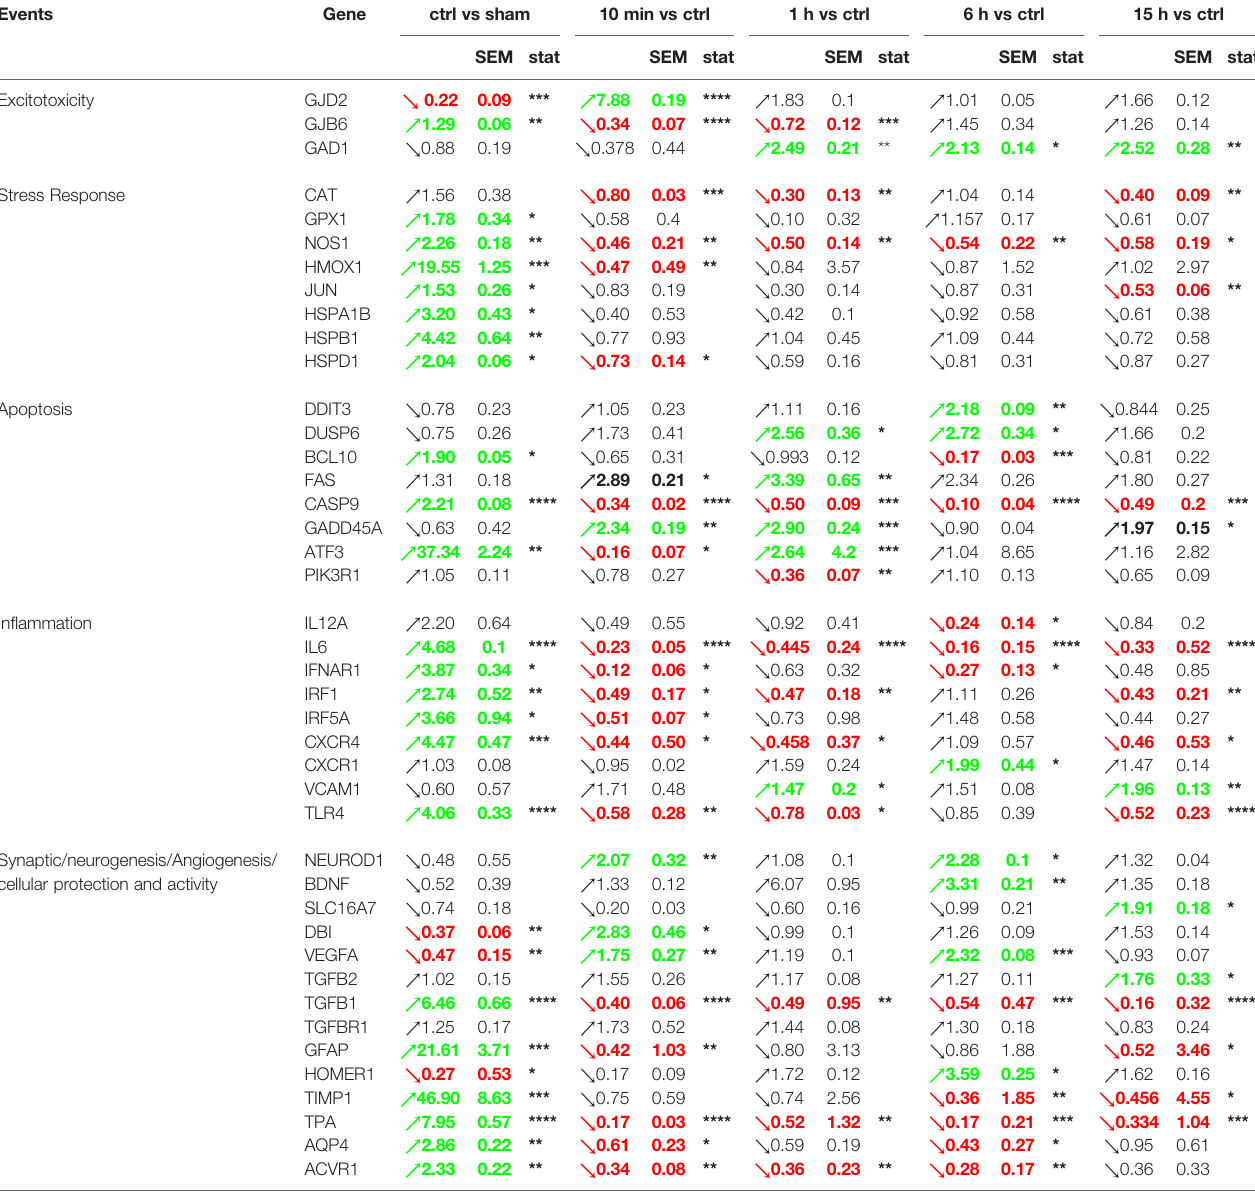
TABLE 1 | Effect of acute and delayed IN PACAP administration after reperfusion (tMCAO protocol) on gene expression measured 48 h after the occlusion. Events Gene ctrl vs sham 10 min vs ctrl 1 h vs ctrl 6 h vs